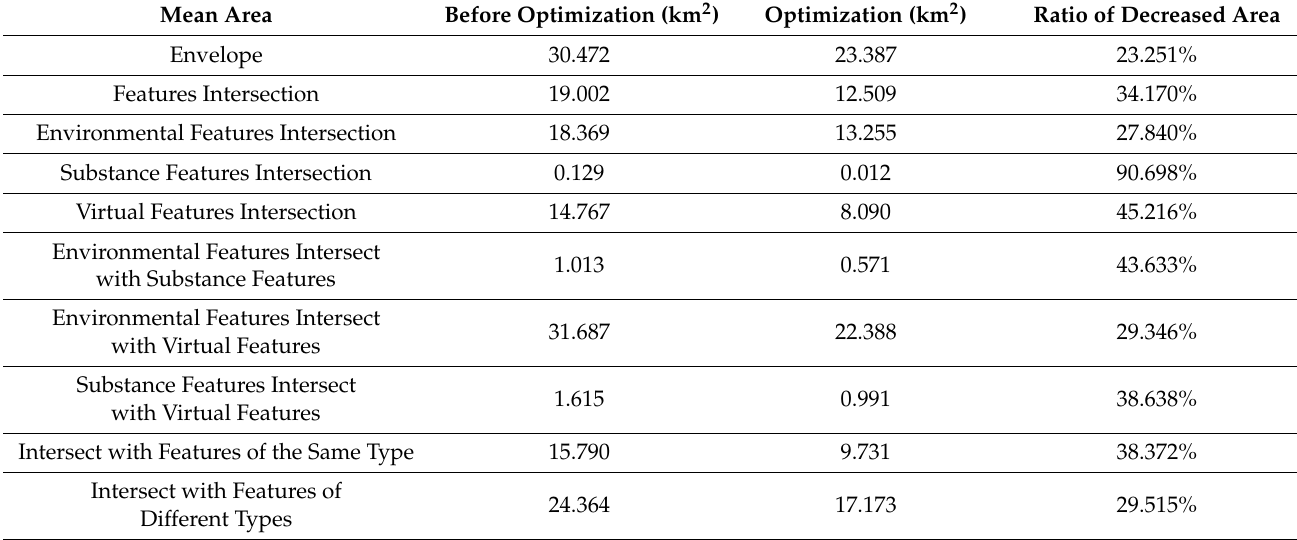
Table 3. Results of overlapping analysis of ENC